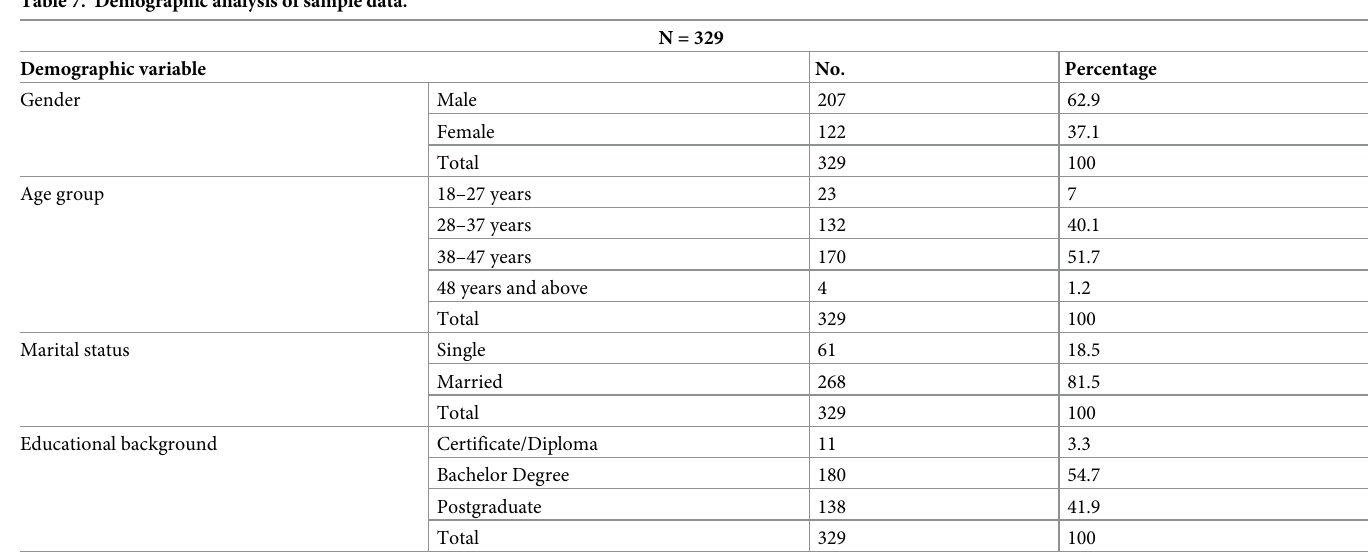
Table 7. Demographic analysis of sample